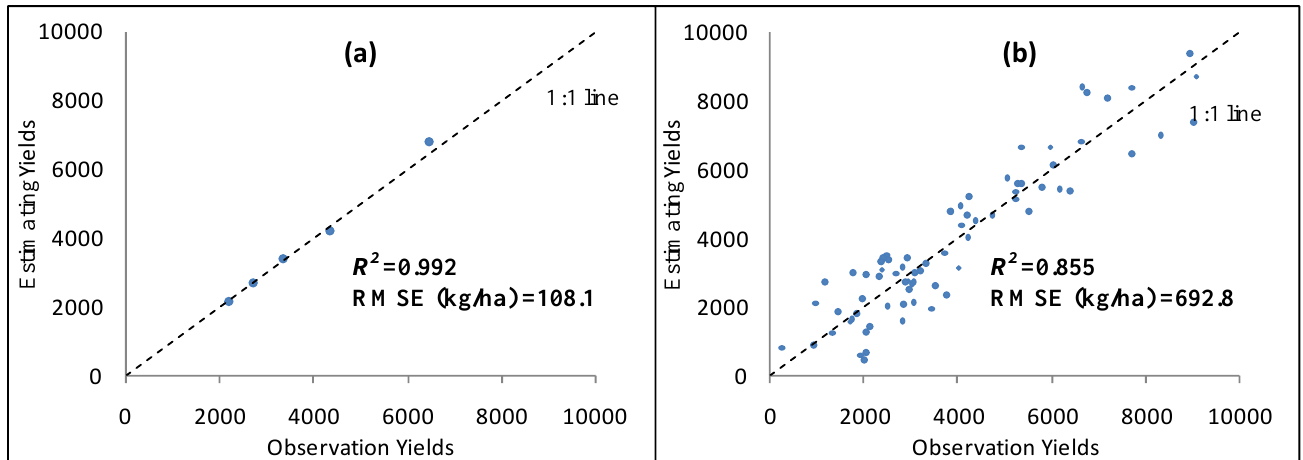
Figure 8. Comparison of average grain yield between SAFY model estimated and situ measurement for five irrigation scenarios ( a ). Comparison of grain yield between SAFY model estimated and situ measurement ( b ).